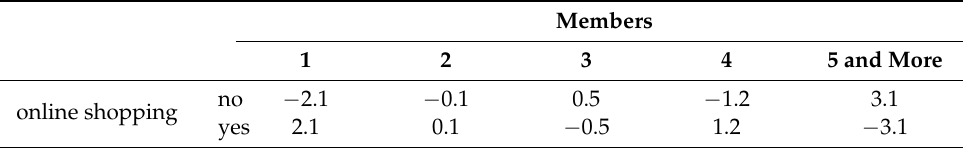
Table 8. Adjusted standardized residuals, cut-off value 2.807 (variables online organic food purchases and number of persons in the